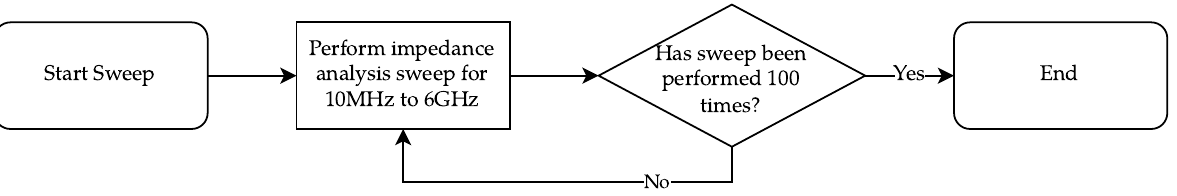
Figure 2. Flowchart of the specific experimental process for the